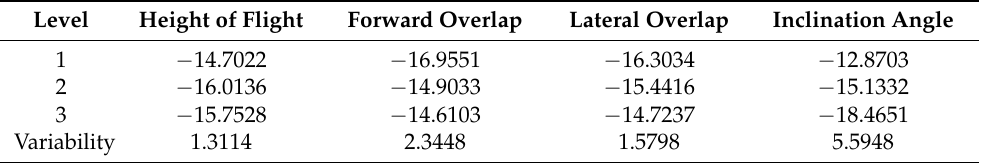
Table 8. Average signal-to-noise ratio for each factor and level and variability.